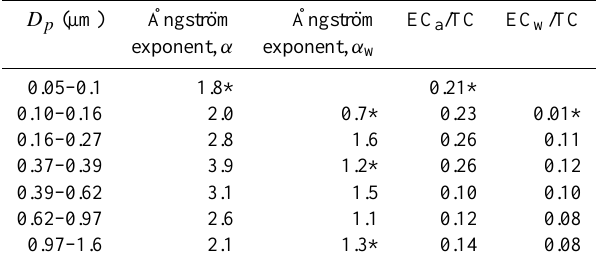
Table 4. Comparison of the size-resolved ˚Angstr¨om exponent and the EC/TC